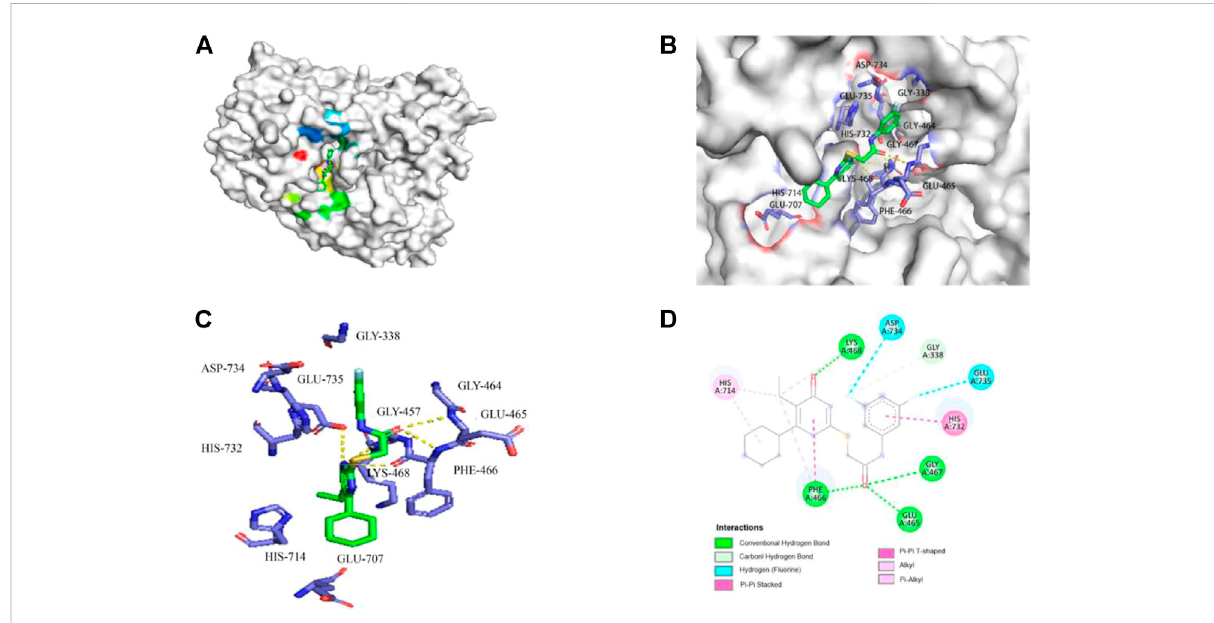
FIGURE 4 Moleculardockingmodelof 4w andZIKVRdRp. (A)4w bindstoZIKVRdRpwithlowerfreeenergy,thecompoundisshowninstickform,andthe amino acid interaction site is shown as surface structure; (B) 4w binds to ZIKV RdRp, the compound is shown in green, interacts amino acids are shown in purple; (C) The three-dimensional structure of the interaction between 4w and ZIKV RdRp is magni fi ed, 4w is shown in green, the interacting amino acids are shown in purple, and the intermolecular hydrogen bond force is marked with a yellow dotted line; (D) The interaction map between 4w and each amino acid of ZIKV RdRp protein, the intermolecular hydrogen bond force is shown in green.